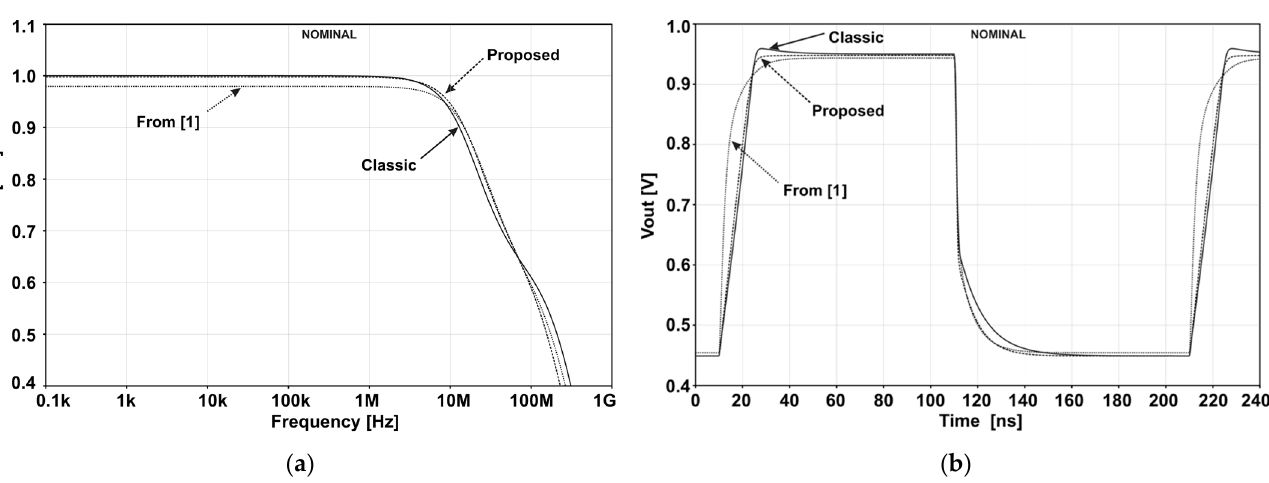
Figure 3. Simulated dynamic characteristics: ( a ) the small-signal gain characteristic; ( b ) the large-signal pulse response. Nominal (corner) models of transistors are used.